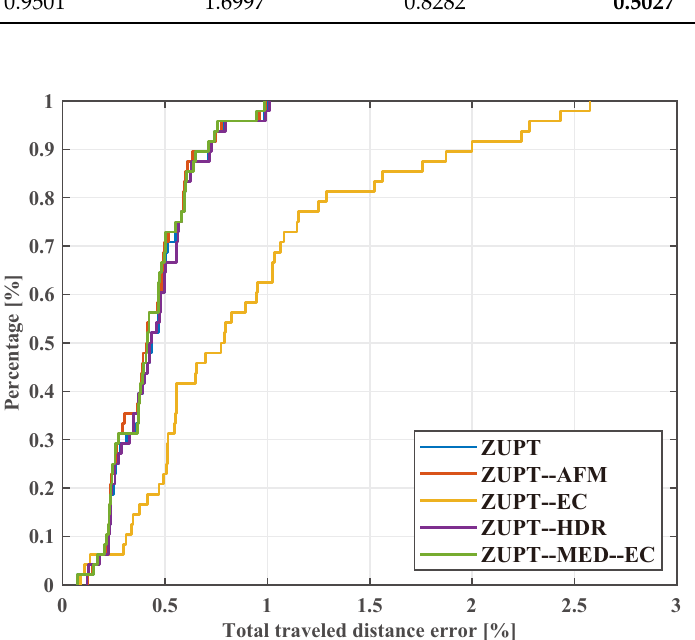
Figure 9. Total traveled distance error (TTDE) CDF curves of different frameworks on indoor dataset 1.